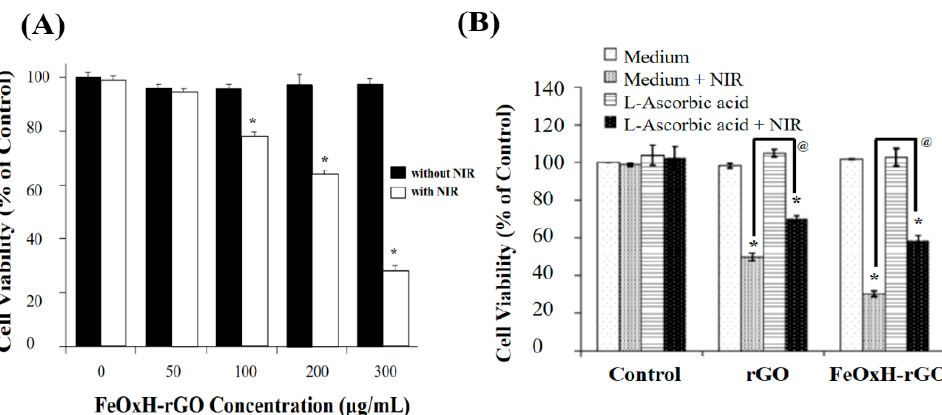
Figure 4. In vitro phototherapeutic effect of FeOxH–rGO nanocomposites. ( A ) Cell viability of T47D cells after treatment with various concentrations of FeOxH–rGO with or without laser irra-diation for 5 min. ( B ) Cell viability of T47D cells after incubation with medium, rGO, FeOxH–rGO and L-ascorbic acid, followed by NIR irradiation. The power density of NIR used in this set of ex-periments is 1.82 W/cm 2 and irradiation for 5 min. * p < 0.05 indicates statistically significant dif-ferences from the control. @ p < 0.05 indicates statistically significant differences from rGO-treated or FeOxH–rGO-treated T47D cells with NIR illumination.